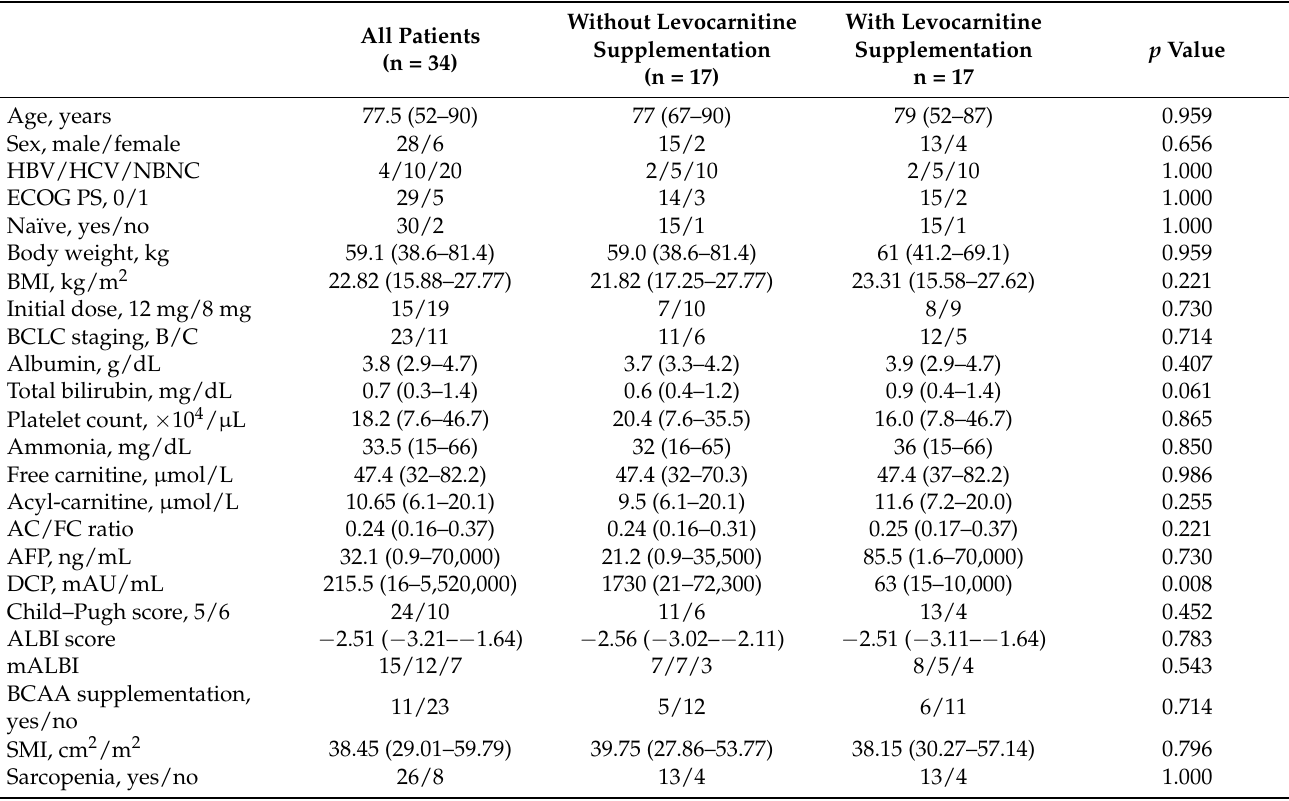
Figure 1. Flow chart of patients included in this study. BCAA—branched-chain amino acid; CT—computed tomography; mALBI—modified albumin-bilirubin grade. Table 1. Comparison of baseline characteristics in patients without and with levocarnitine